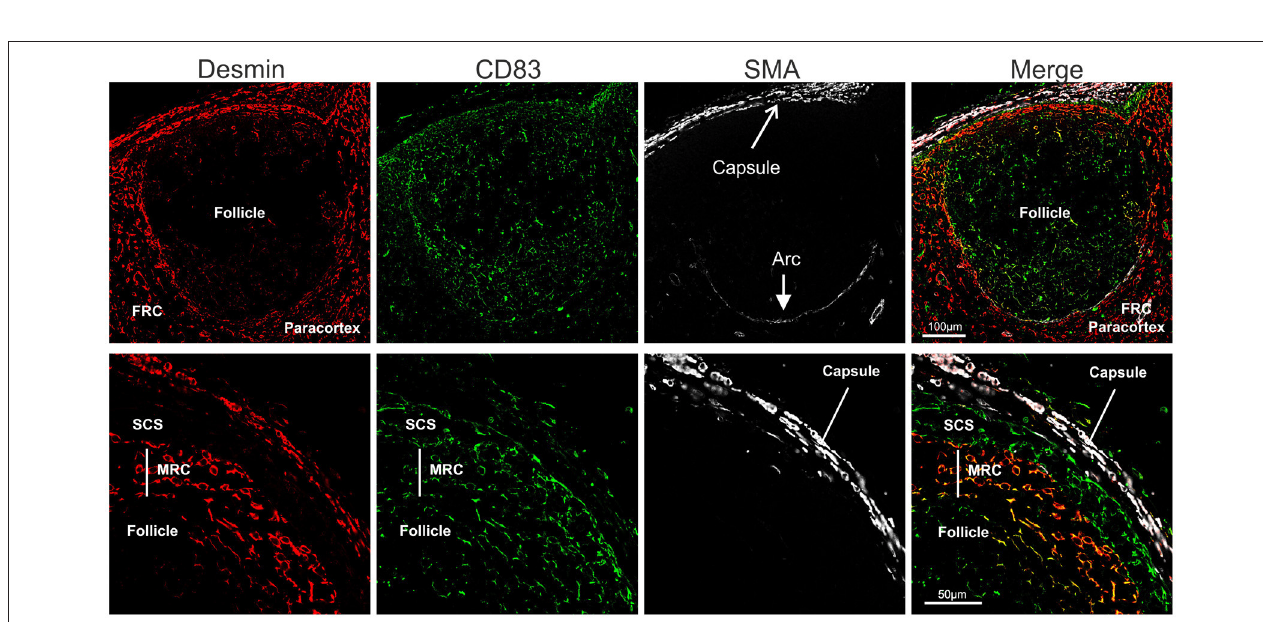
FIGURE 6 | Identification of sheep fibroblastic reticular cells (FRC) and marginal reticular cells (MRC). Representative confocal micrographs of sheep lymph node sections. Sections were stained for desmin (rabbit polyclonal, red), CD83 (green), and SMA (white) to identify desmin + CD83 − FRC in the paracortex, desmin − CD83 + MRC between follicle and subcapsular sinus, and desmin − CD83 + dark zone FDC in the follicle. SMA identifies the capsule of the LN.